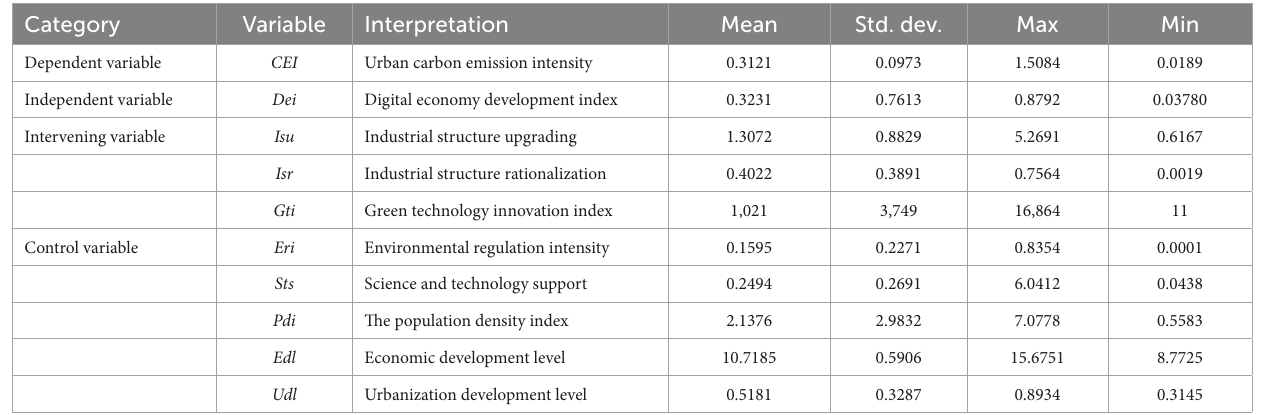
TABLE 2 Variables’ explanatory and descriptive